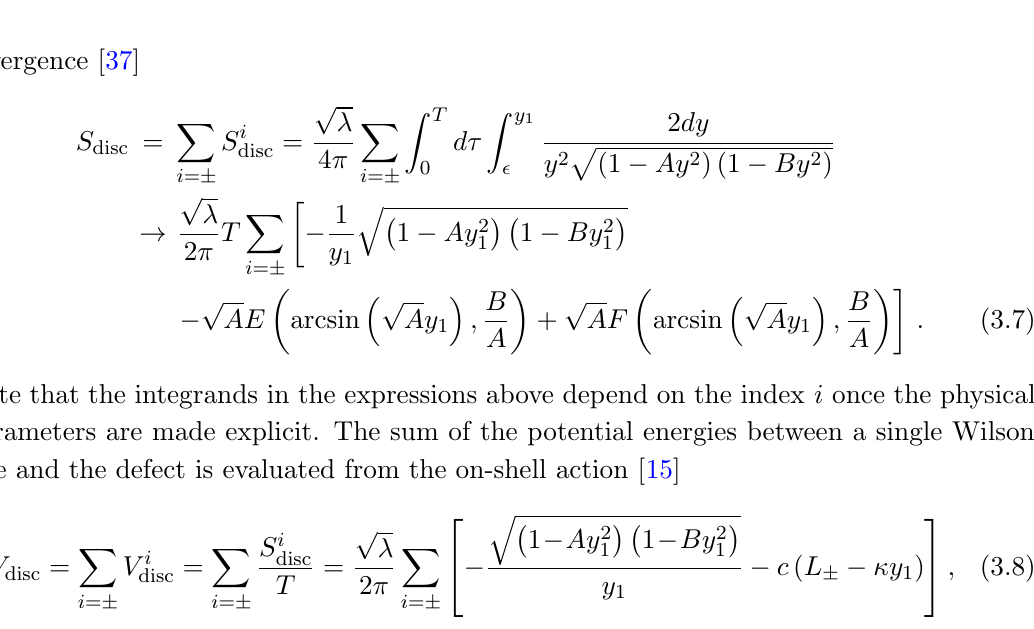
Figure 3 . Contour plot of the coe(cid:14)cient C disc of the particle-defect potential (3.9) as function of (cid:31) and (cid:20)